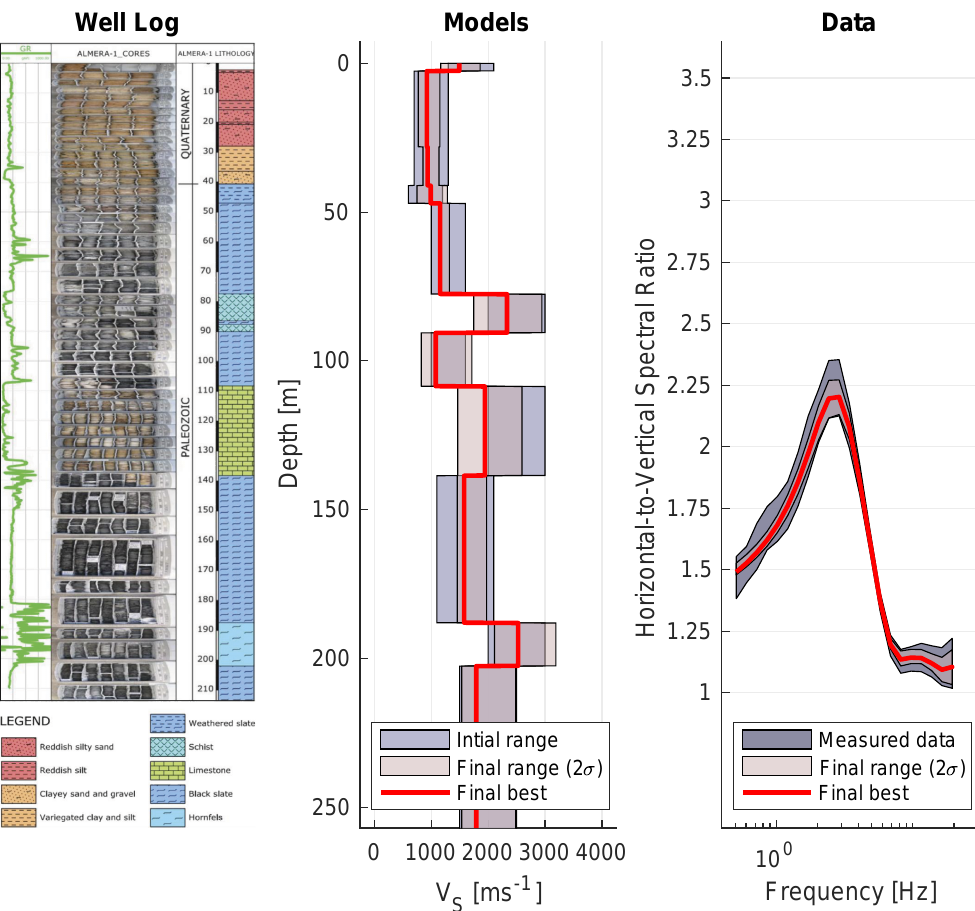
Figure 5. Well-log, models and data for ICJA station obtained with MEMD. Well-log column taken from